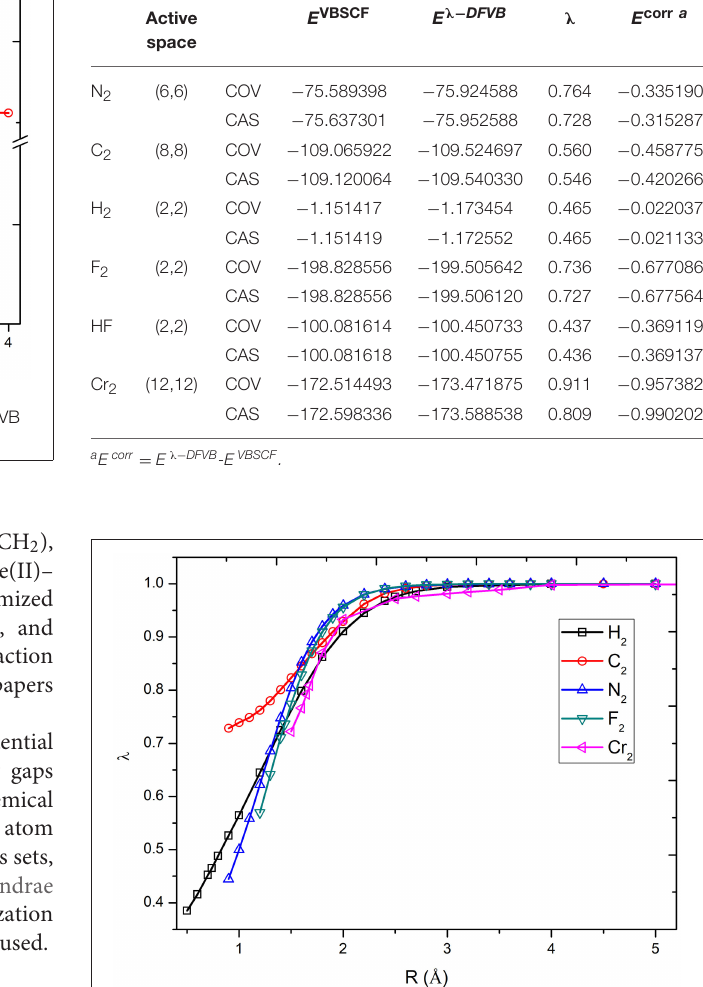
TABLE 1 | The λ -DFVB energies of H 2 , F 2 , HF, Cr 2 , N 2 , and C 2 energies with variable λ values at their equilibrium geometries (a.u.). Active space